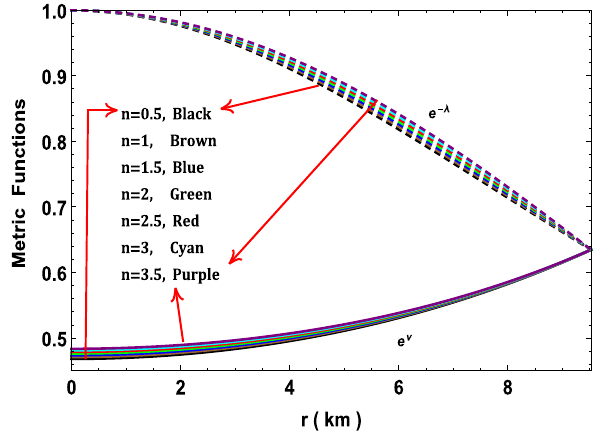
Fig. 1 Variation of metric functions with radial coordinate r for 4U 1608-52 ( M = 1 . 74 M (cid:9) , R = 9 . 528 km) by taking a = 0 . 001 km − 2 and β = 0 .